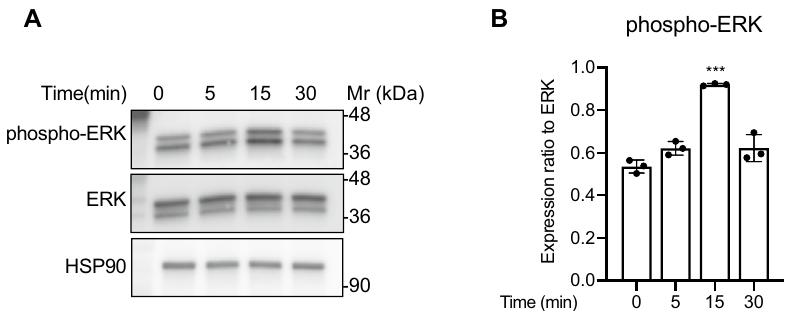
Figure 3. Phosphorylation of ERK is increased by CCN2. ( A ) LECs were stimulated with 100 ng/mL CCN2 for 0, 5, 15 or 30 min, and phosphorylated ERK, total ERK and HSP90 were detected by Western blotting. ( B ) Quantification of protein bands from ( A ); phospho-ERK level was normalized with total ERK. One-way ANOVA, *** p < 0.001 versus 0